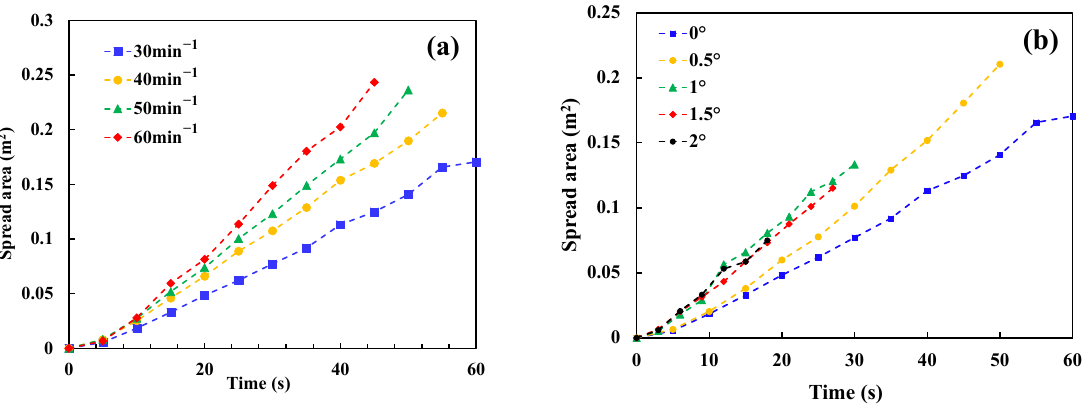
Figure 3. ( a ) Relationship between spread area and flow rate for the flat surface; ( b ) The spread areas as function of the discharge times for the tests with the same discharge rate (30 rad/min). will not only increase with the increase of discharge rate, but also with the increase of slope.